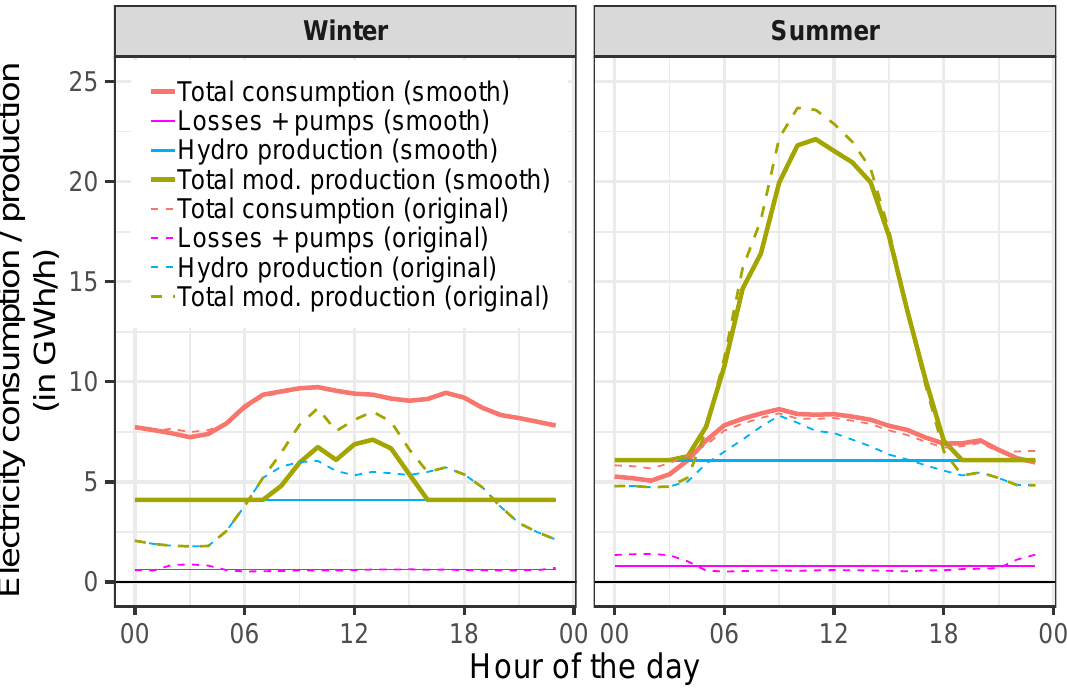
Figure 11. “Smoothed” (averaged) and “original” (unadjusted) profiles of the Swiss electricity consumption and modified production for one randomly selected day in winter and summer. A proper description of each line can be found in Table